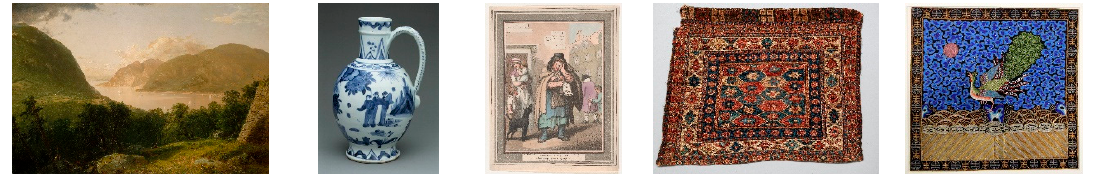
Figure 2. Some artworks from the Metropolitan Museum of New York (MET) dataset.